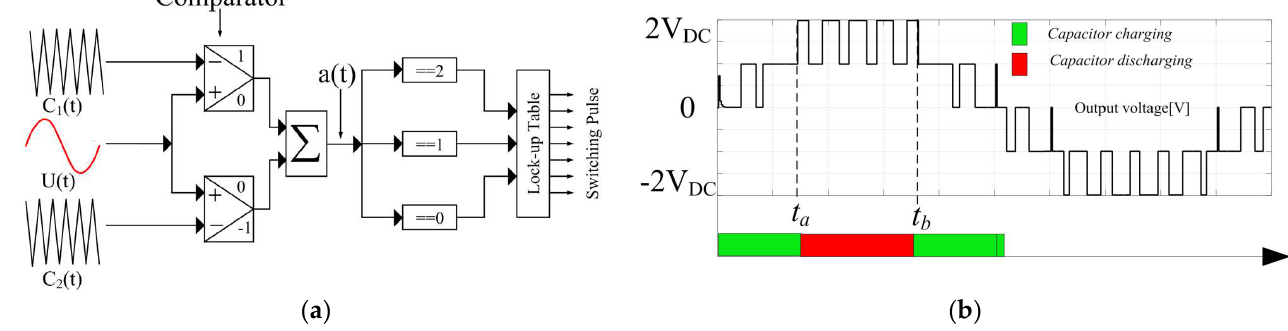
Figure 4. The proposed 3-Ф five-level MLI. ( a ) Switching scheme for per phase leg; ( b ) Output voltage.